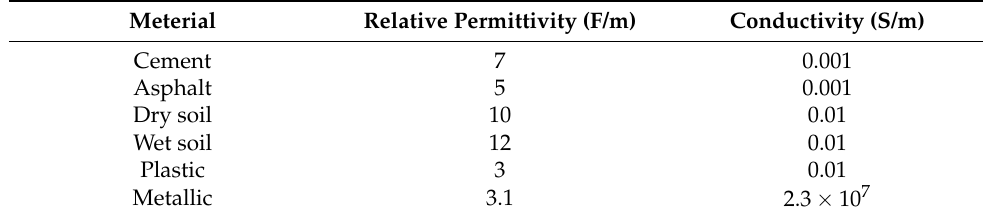
Table 1. Electromagnetic properties of the material.